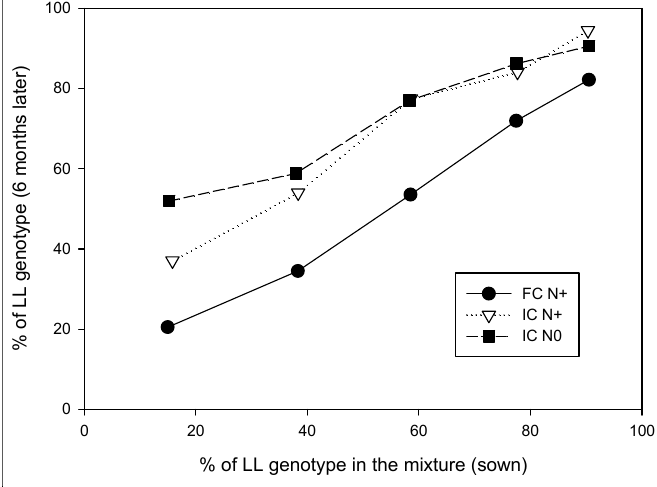
Figure 1. Genotypic responses of mixtures under three management regimes showing a decrease in the percentage of short-leaved genotypes under infrequent cutting and no change under frequent cutting. (FC N+, frequent cutting with nitrogen; IC N+, infrequent cutting with nitrogen; IC N0, infrequent cutting with no nitrogen). LL: long-leaved genotype. Figure from